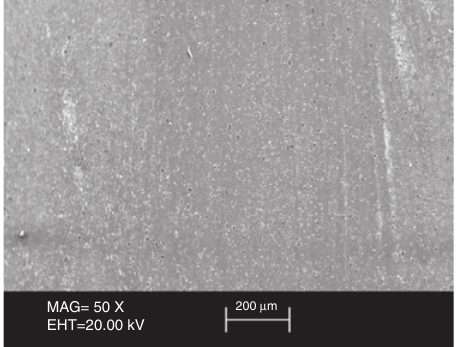
Figure 12 SEM microstructure image of the N7 sample.